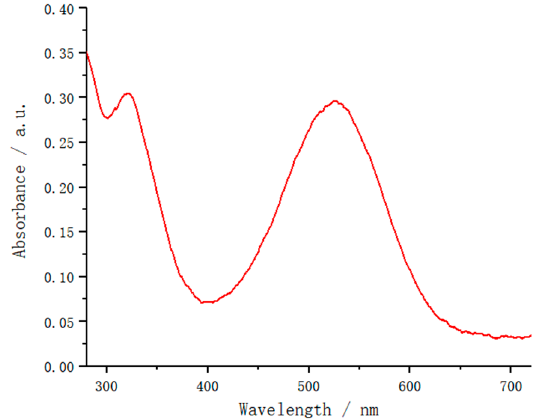
Figure 5. The UV-Vis absorption diagram of BTN solution in methylene chloride.